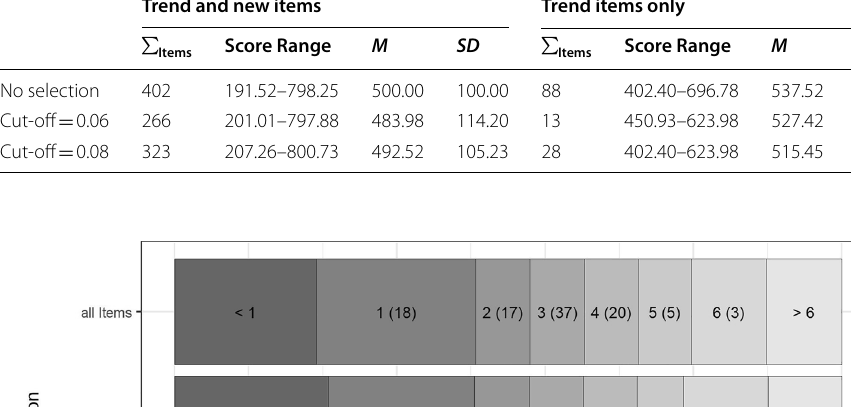
Table 1 Comparison of the item difficulties before and after item selection Trend and new items